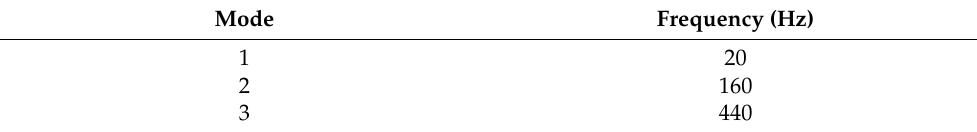
Table 1. Natural frequencies.